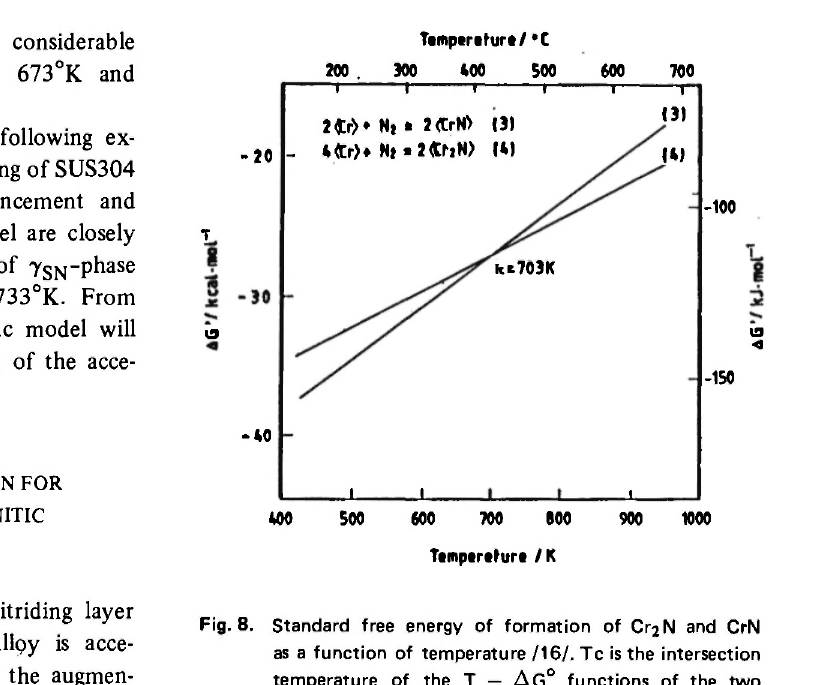
Fig. 8. Standard free energy of formation of Cr 2 N and CrN as a function of temperature /16/. Tc is the intersection temperature of the Τ — A G 0 functions of the two chromium nitrides formed by equations (3) and